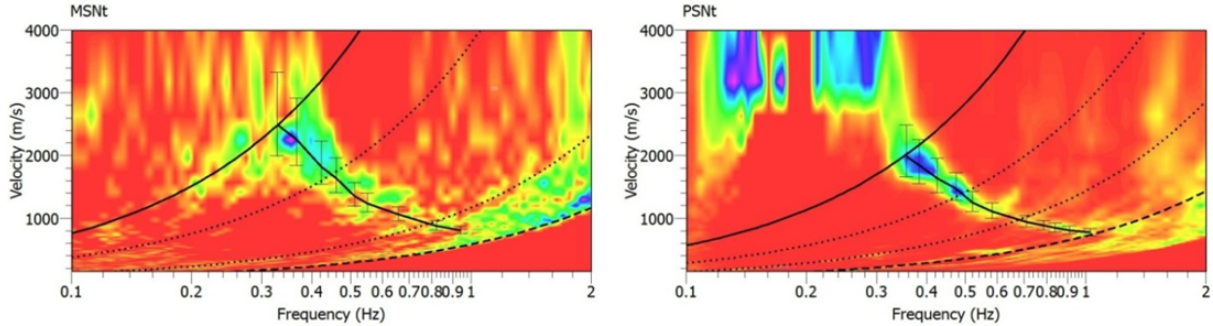
Figure 6. Picked dispersion curves (black continuous line) with relative error bars obtained for MSNt and PNSt. The dotted line is k min / 2 = k max / 2 , the thick dashed line is k min and the thick is line k max .